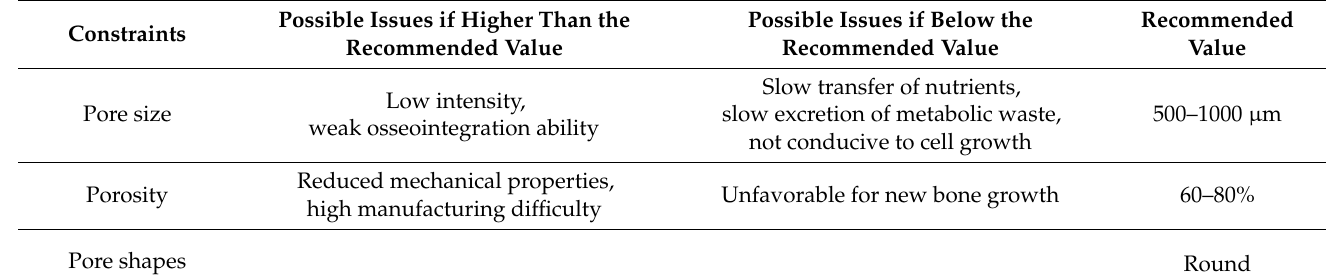
Figure 6. ( a ) Scaffold with different pore shapes and ( b ) unit cells (Adapted with permission from Jahir-Hussain et al., 2021) [79]. Table 3. Impact of design constraints on bone scaffolds.